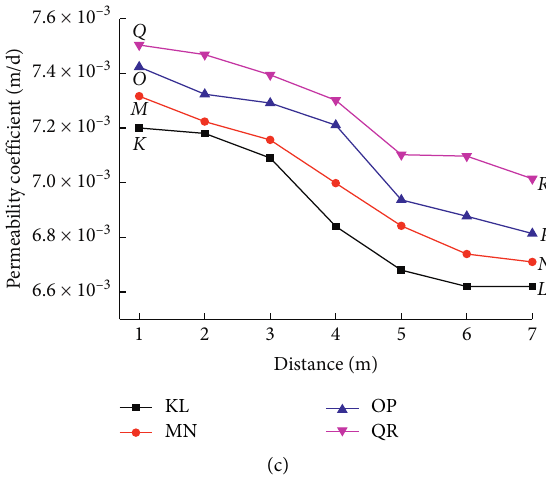
Figure 19: Permeability coefficient of horizontal and vertical direction in surrounding rock. (a) Sketch map. (b) Horizontal direction. (c) Vertical